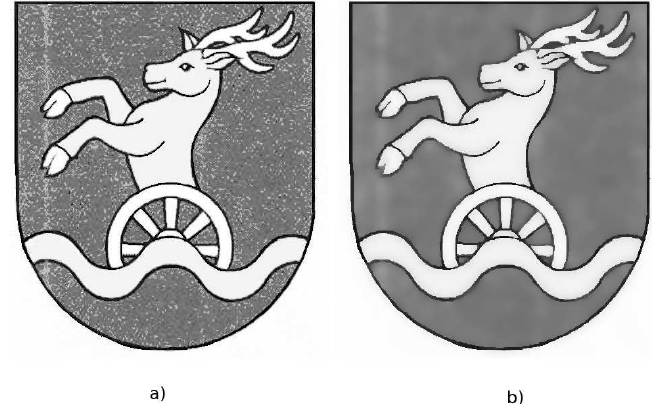
Figure 1. Example. a) the original image, b) the smoothed